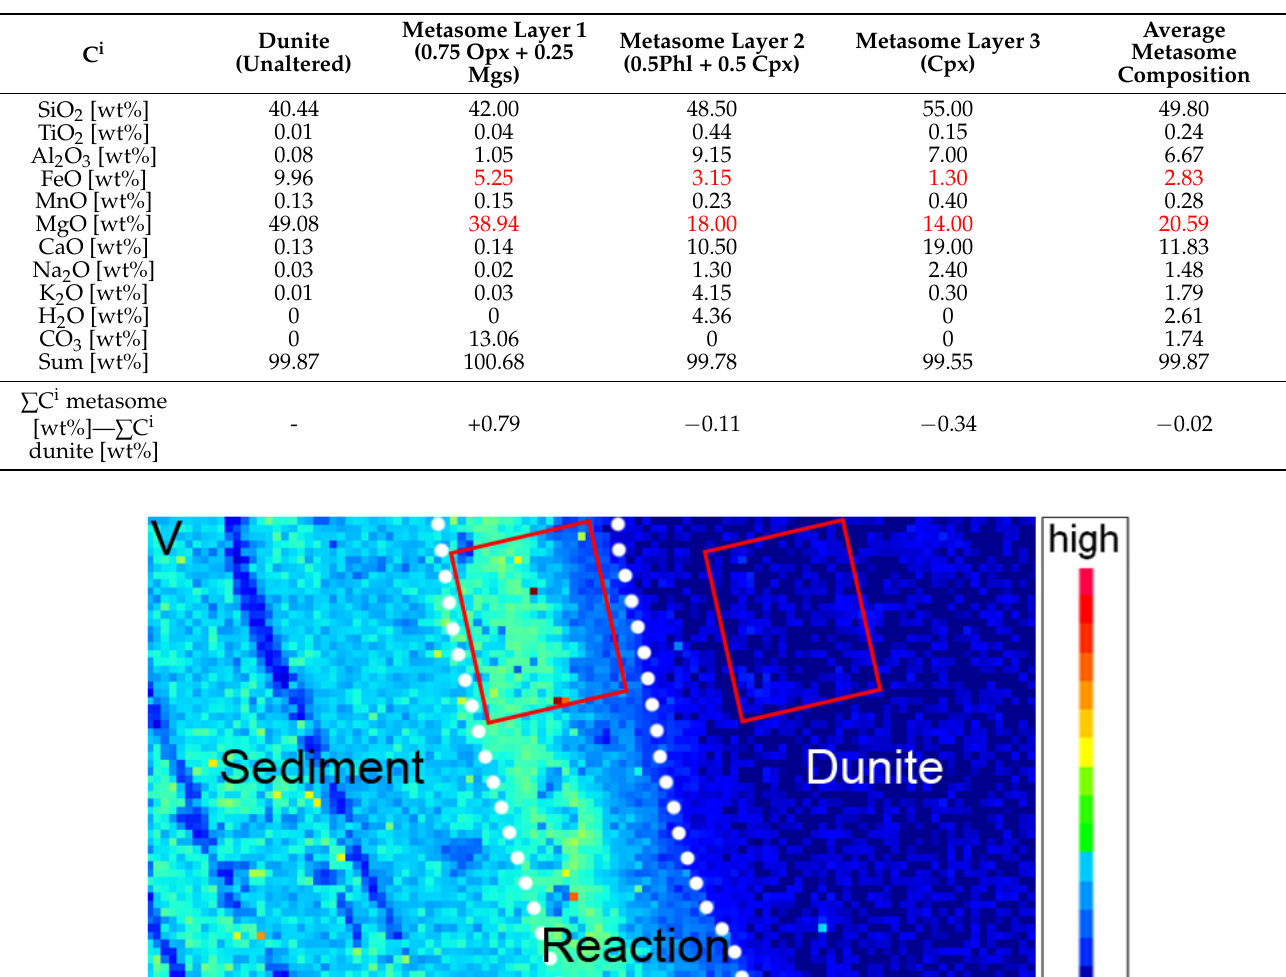
Table A4. Gresens-Grant analysis of the metasomatic layers of experiment 4 (3 GPa/850 °C). Oxide species depleted within the metasomatized layers are highlighted in red.